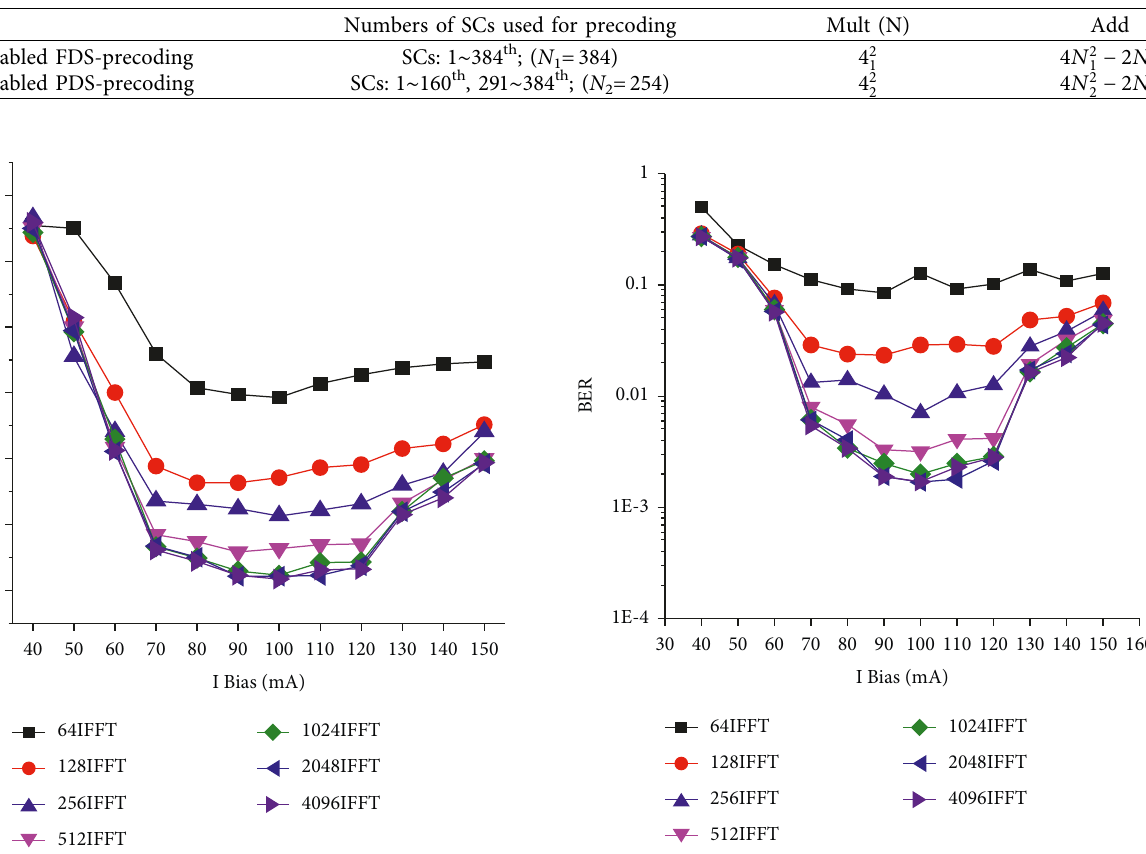
Table 1: Implementation complexity comparison.